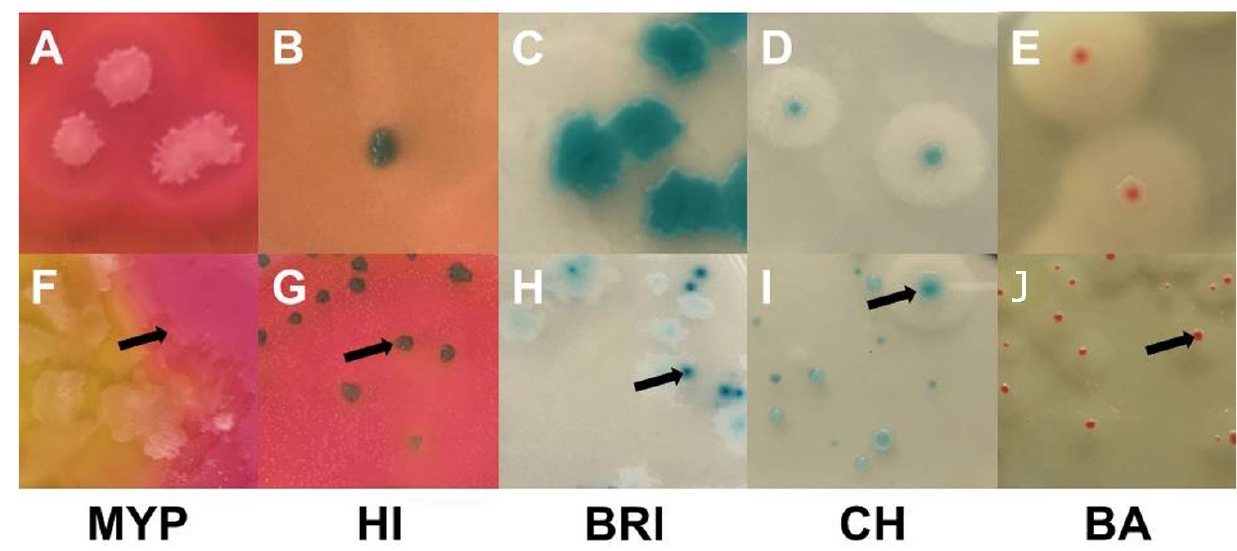
Figure 4. Examples of typical Bacillus cereus sensu lato colonies obtained by sampling of naturally contaminated food ans milk samples . Demarcated colonies with typical morphology (top row):